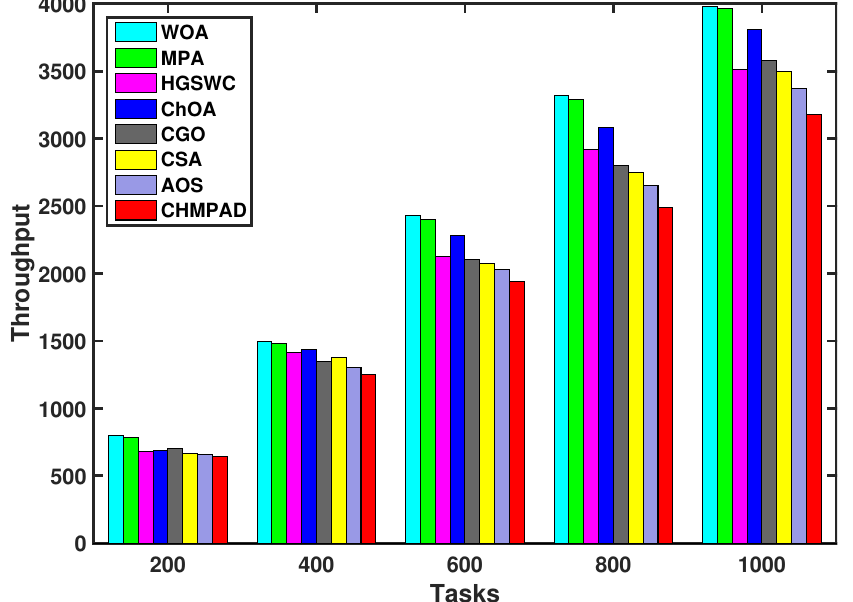
Figure 3. Average throughput time—synthetic